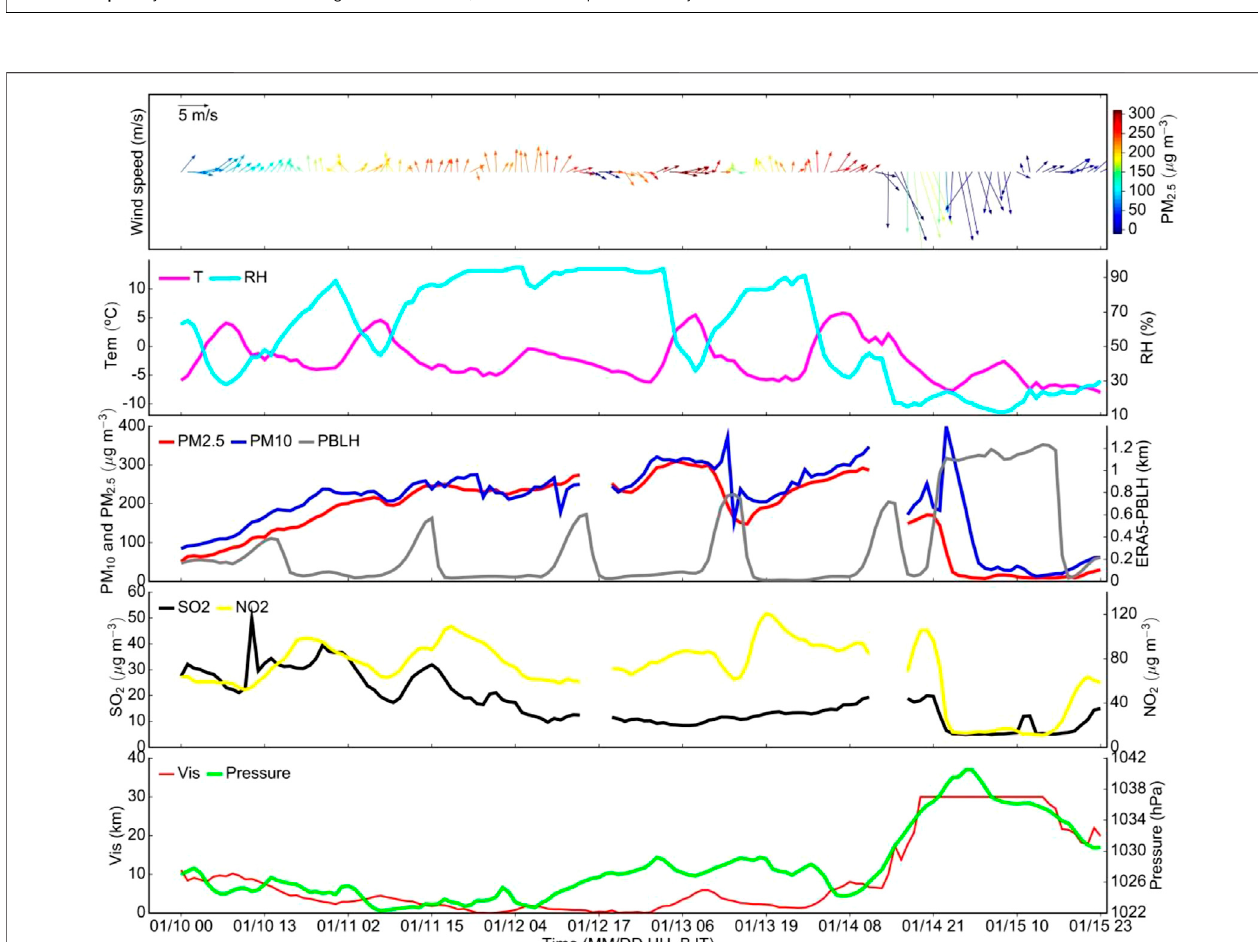
FIGURE 2 | Time series variations in visibility, PM, gaseous pollutants, PBL height, and meteorology parameters from 10 to 15 January 2019 in Tianjin.